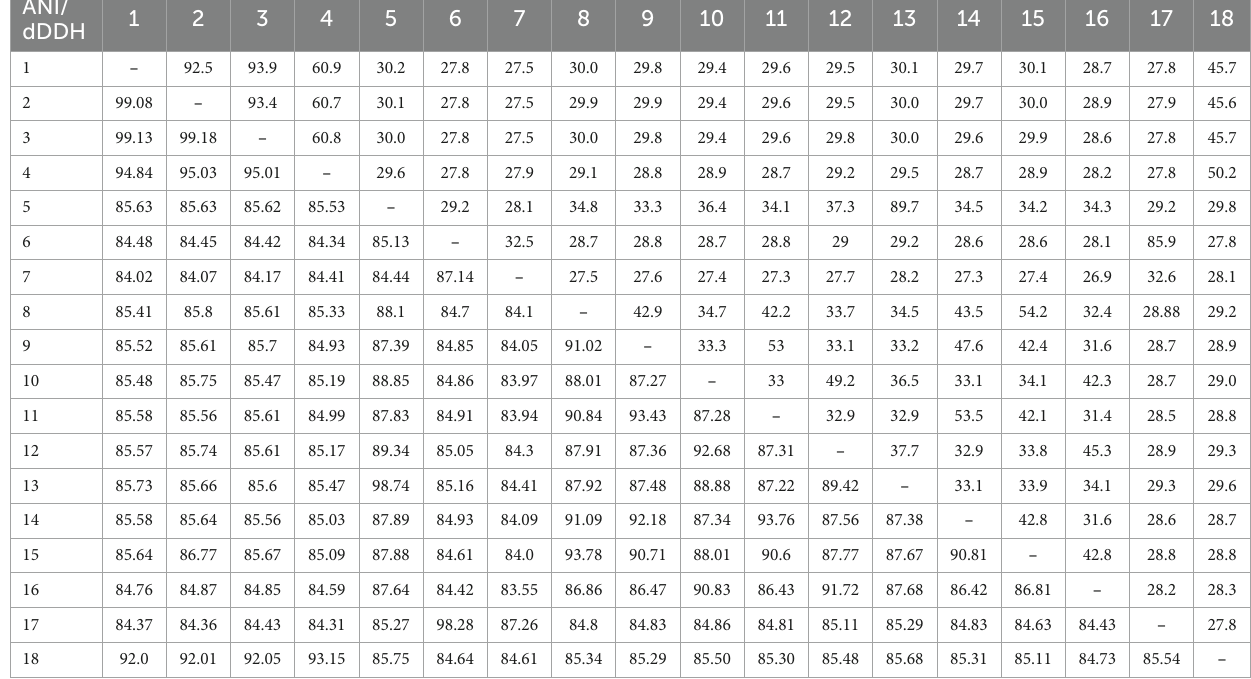
TABLE 2 Pairwise average nucleotide identity (ANI, bottom left) and digital DNA-DNA hybridization (d 4 DDH, top right) among ChDrAdgB13 and JaDmexAdg06 strains, and nominal Rahnella species. ANI/ dDDH